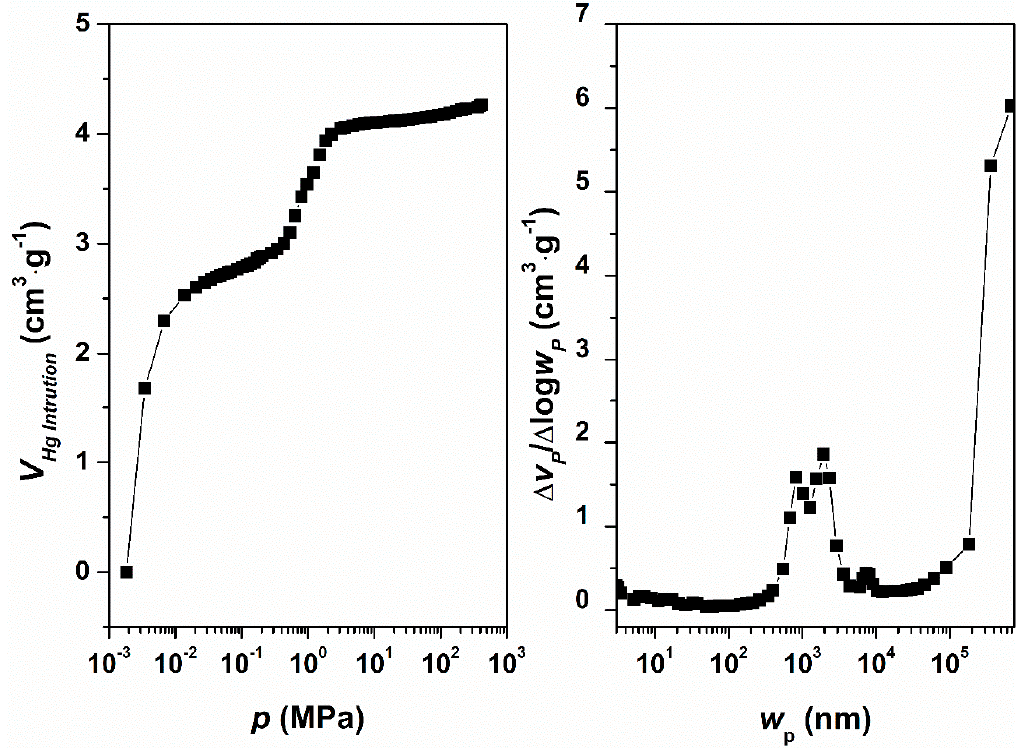
Figure 8. Hg intrusion porosimetry curve (left) for the diatomite and the corresponding macropore-size distribution (right), resulting in smaller-size macropores around 850–2000 nm and bigger than 400 µm.